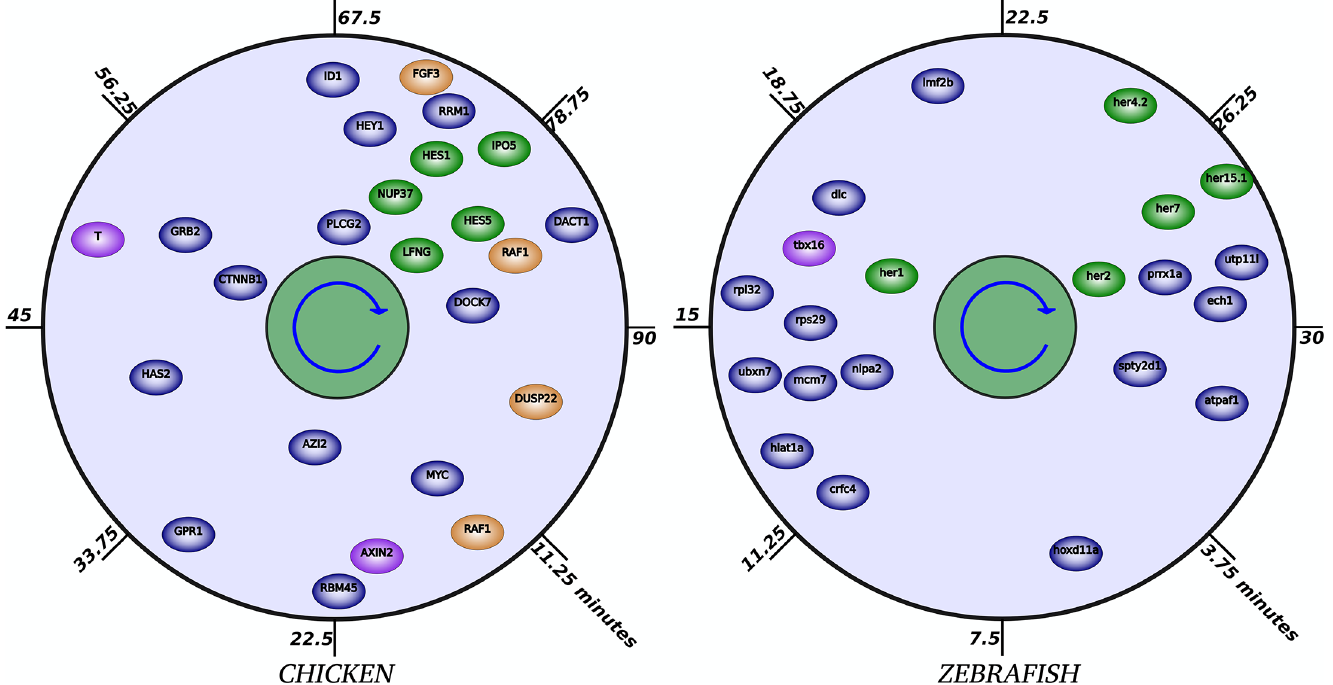
Fig 3. The timing of the significant genes involved in the chicken and zebrafish somitogenesis. Position of a gene symbol on the plots reflects time of peak timing (angle; clockwise) and the mean expression level (genes with high expression level are closer to the center). The timing is based on 90 and 30 minutes periodicity for the chicken and zebrafish somite cycle respectively. Genes are color-coded according to their known pathway association with green for Notch, brown for Fgf, and purple for Wnt. Genes in blue have never been reported as cyclic but are regulated during chicken and zebrafish somitogenesis. Also, a comparison with Fig 3 of [15] suggests that notable similarities exist between the temporal organization of the pathways involved in the somite clock in chick and mouse, with certain aspects (as the phase of expression of Notch genes) conserved also in the